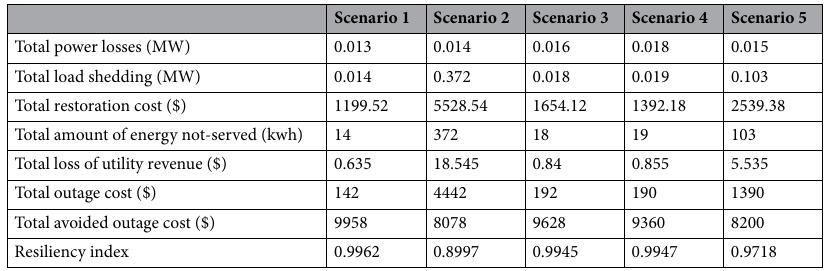
Table 4. Summary of the objectives and resiliency metrics for the five scenarios with EDRP and Tie-line.